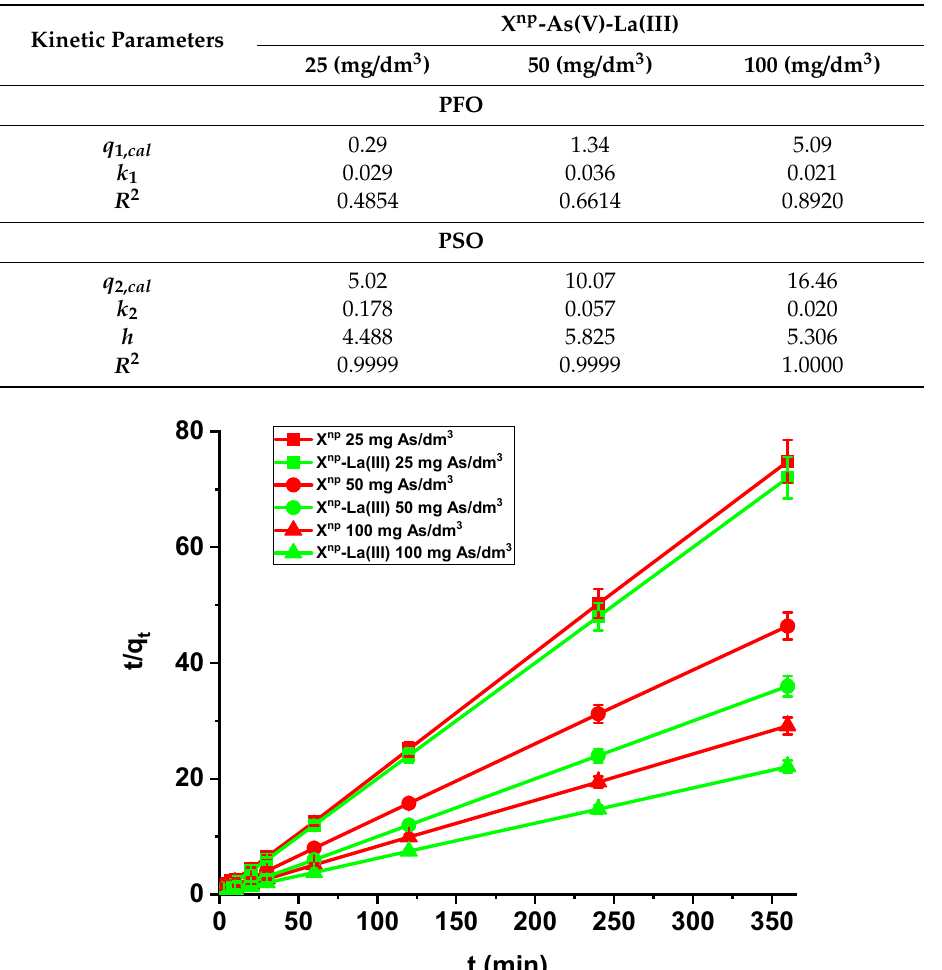
Figure 13. PSO plots of arsenic(V) adsorption on X np (red) and X np -La(III) (green) (c 0 = 25, 50, 100 mg/dm 3 , pH 6, shaking speed 180 rpm, temperature 295 K).